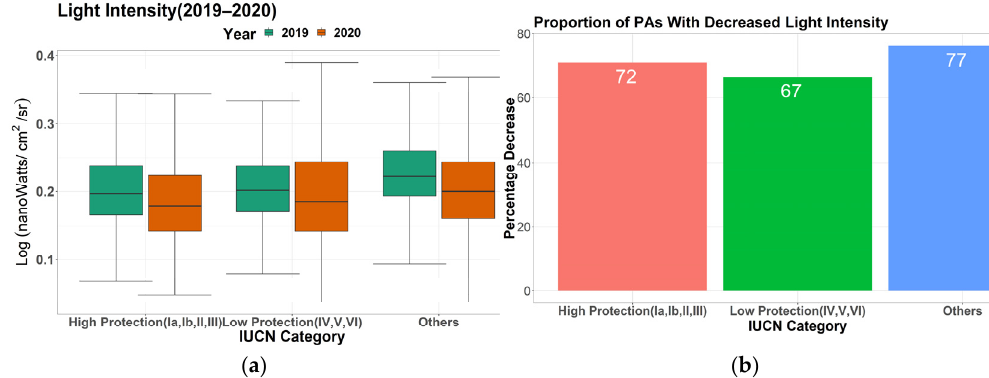
Figure A3. ( a ) Comparison of light intensity across IUCN categories; ( b ) proportion of PAs with decreased light intensity across IUCN categories.